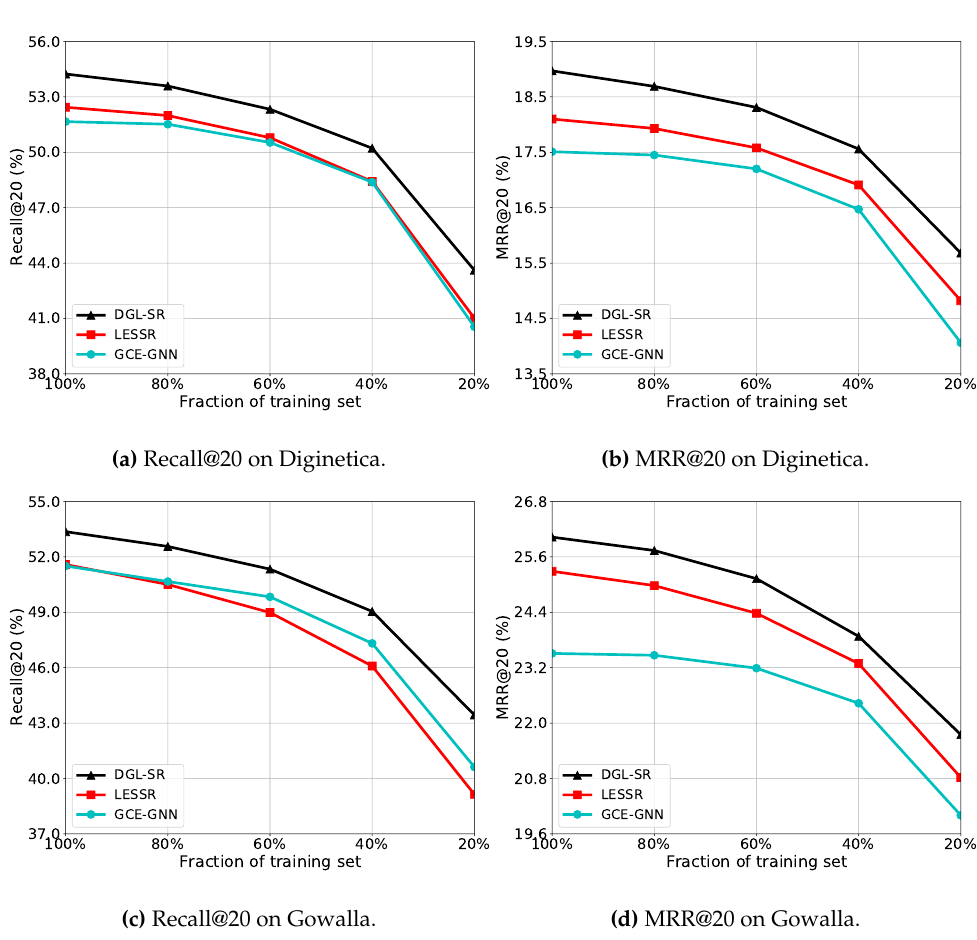
Figure 3. Model performance on different fractions of training